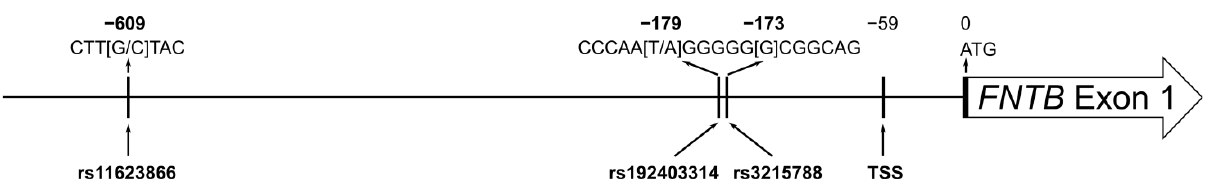
Figure 1. The FNTB promotor region. The schematic representation shows the local sequences and positions relative to ATG. The polymorphisms of interest are indicated.